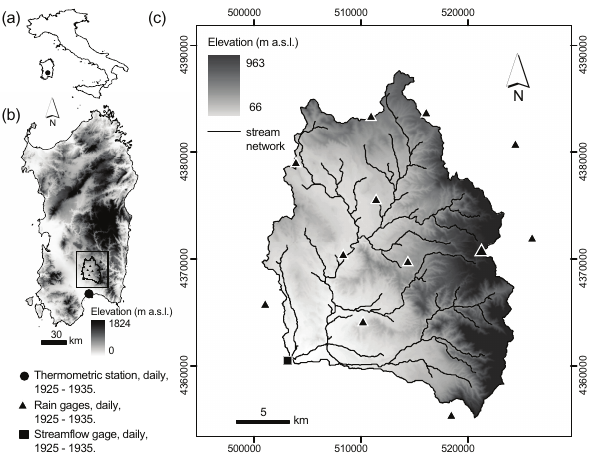
Fig. 1. Location of the Rio Mannu di San Sperate at Monastir basin (RMB) within (a) Italy and (b) the island of Sardinia. (c) Digital elevation model (DEM) of the RMB including UTM coordinates. Panels (b) and (c) also report the position of the thermometric station, rain gages and streamflow gage at the basin outlet with daily data observed during the years 1925-1935.